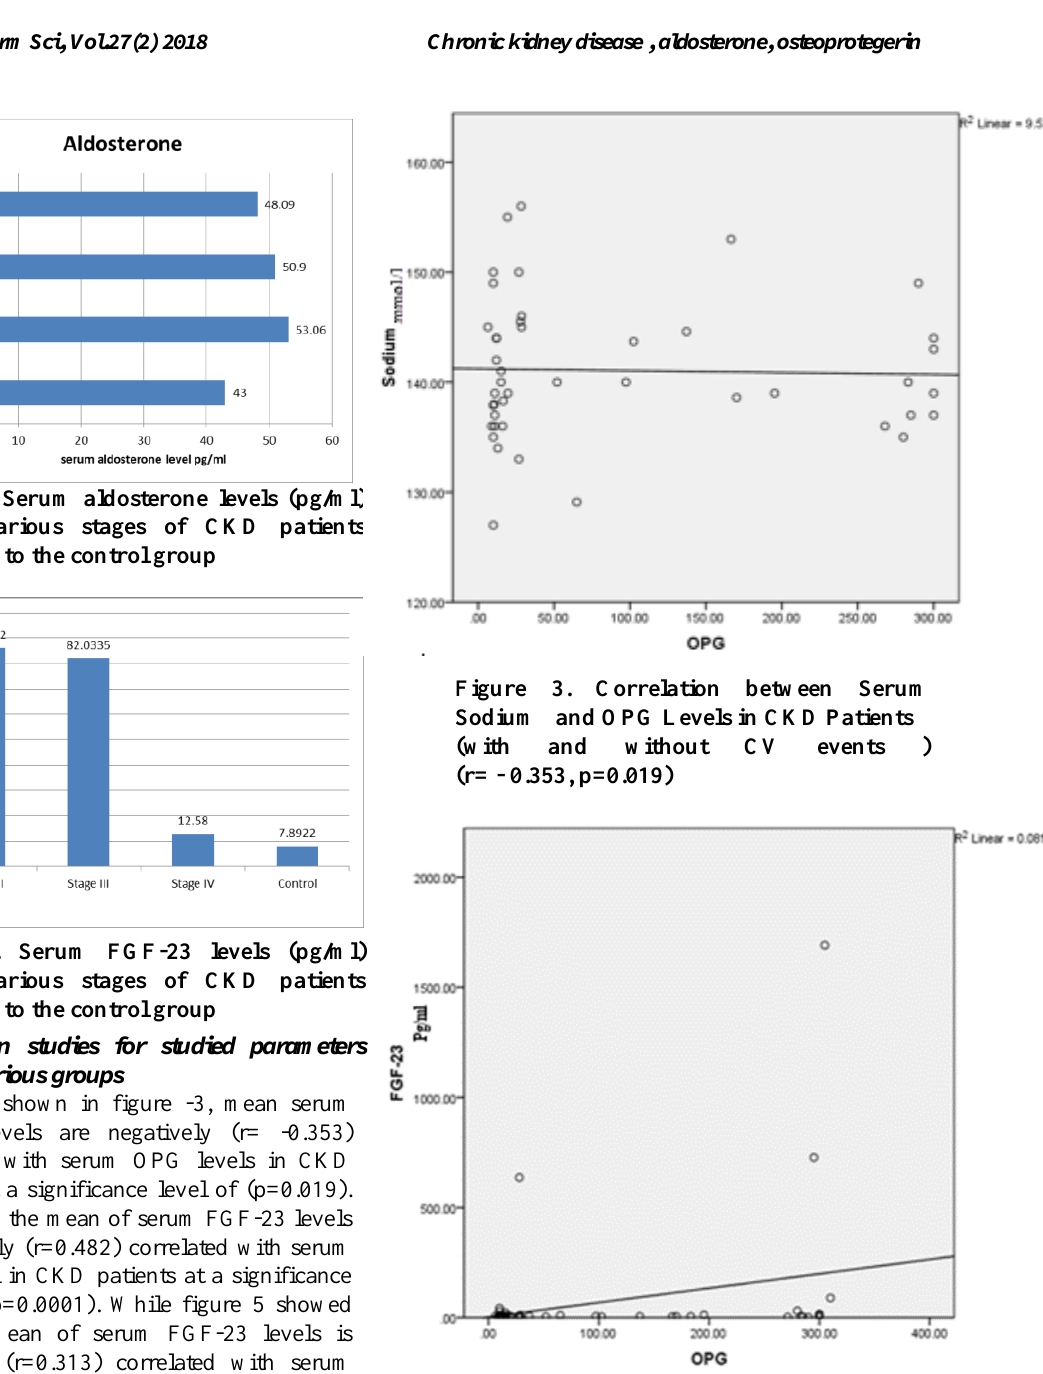
Figure 4. Correlation between Serum OPG and FGF-23 Levels in CKD Patients with or without CV events (r=0.482 , p